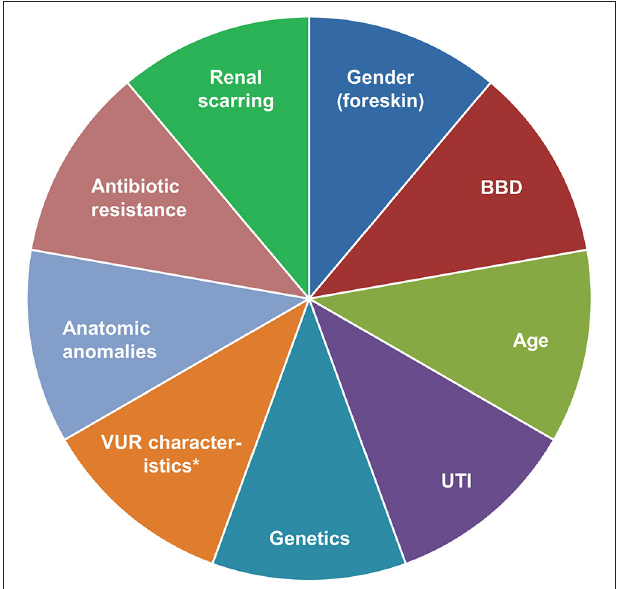
FIGURE 2 | Factors to consider in a risk-based approach to the management of VUR. *Grade, bladder volume at onset of reflux, ureteral diameter ratio. BBD, bladder/bowel dysfunction; UTI, urinary tract infection; VUR, vesicoureteral